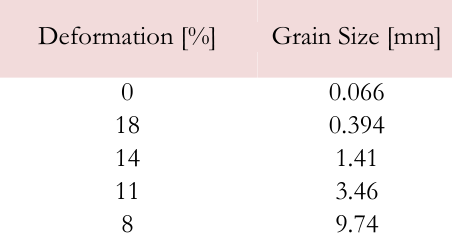
Table 1: Grain size obtained in each thermo-mechanical treatment